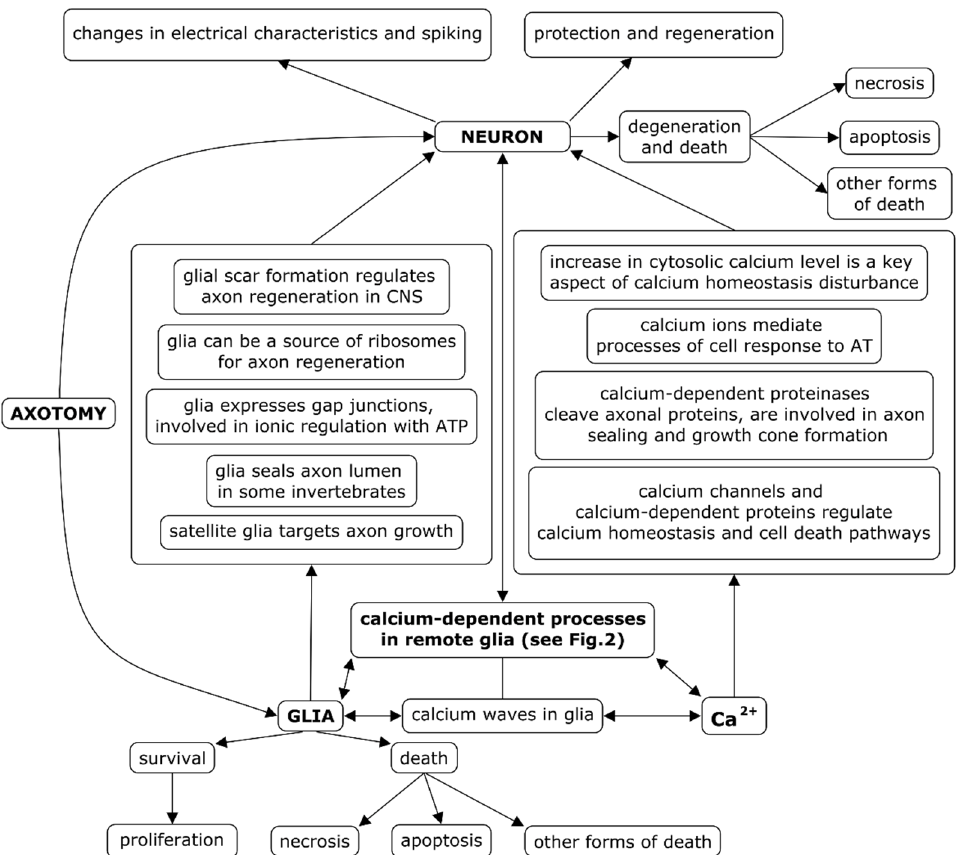
Figure 1. Interactions of neuron, glia, and Ca 2+ ions in the response of neurons and glia to axotomy. Axotomy-induced processes in remote glial cells and their connection with the fate of the neuron (survival and death), as well as the role of Ca 2+ ions in them, are relatively poorly studied.